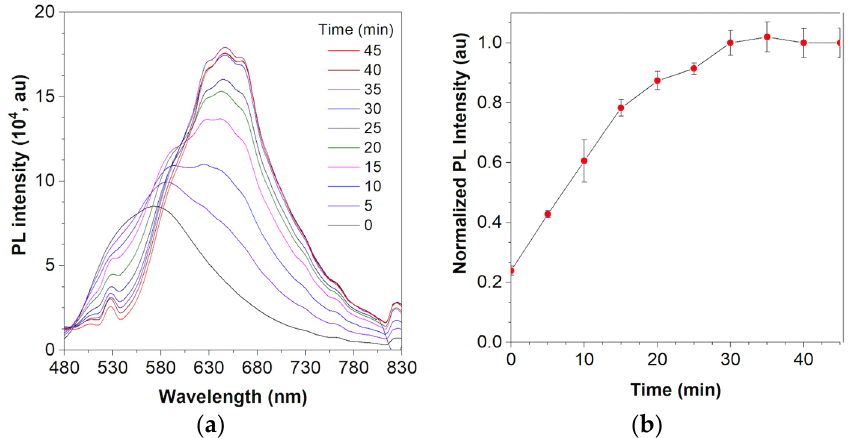
Figure 4. ALP response of HCAP. ( a ) Plot of fluorescence intensity versus incubation time in the presence of 100 mU/mL ALP and 100 μ M HCAP in Tris-HCl buffer (pH 9.2). ( b ) Plot of relative PL intensity (I/I 0 ) at 645 nm versus the incubation time. I 0 = PL intensity at time = 0 min.